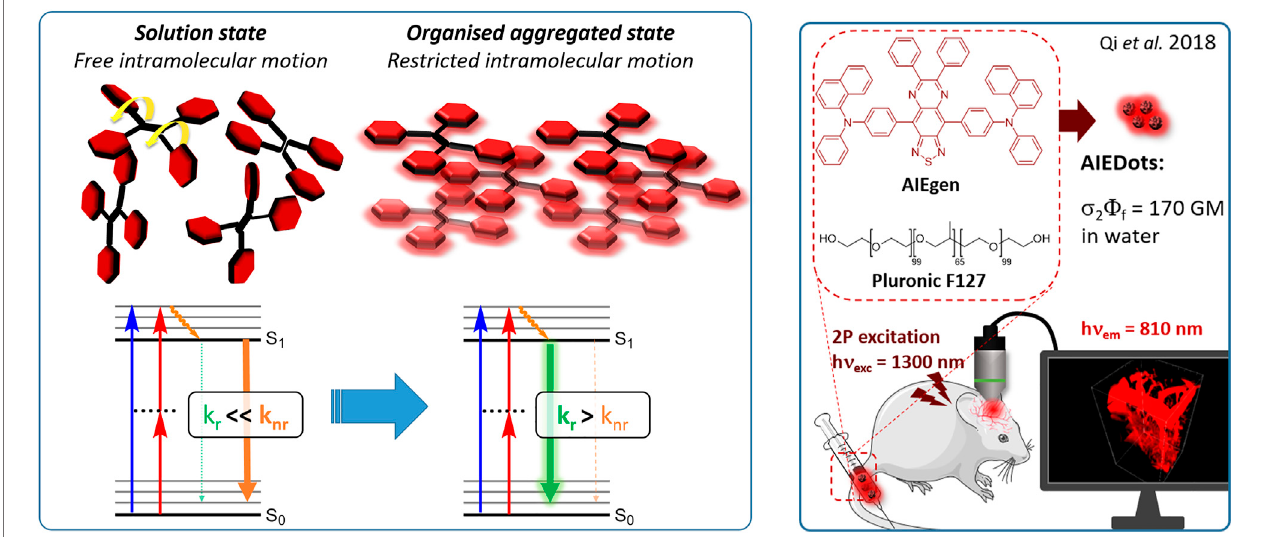
FIGURE 4 | (Left) Illustration of AIEgen molecules in solution and aggregated state, and their corresponding simpli fi ed Jablonski diagrams showing the effect of motion restriction on the radiative (k r ) and non-radiative (k nr ) relaxation pathways after 1PE or 2PE. (Right) Example of in vivo application of 2P microscopy with NIR-II- responsive AIEDots used to reconstruct images of a mouse brain. The 3D reconstruction of mouse brain vasculature is reprinted with permission from ref. (Qi et al., 2018). Copyright 2018 American Chemical Society.